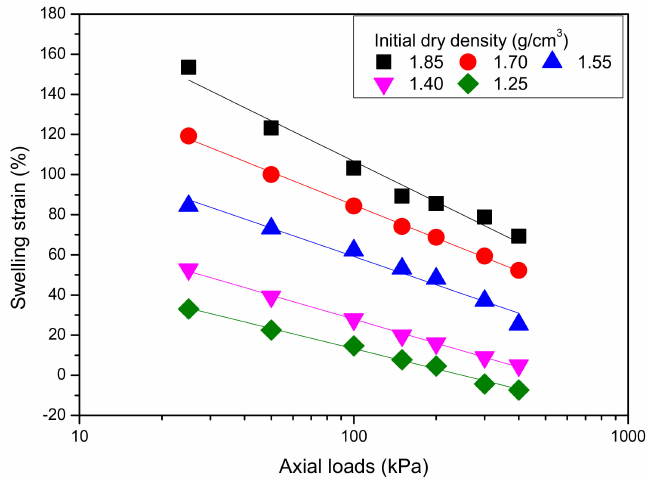
Figure 10. Relationships between the final swelling strains and logarithm of load on MB specimens of different initial dry densities under saline water conditions.